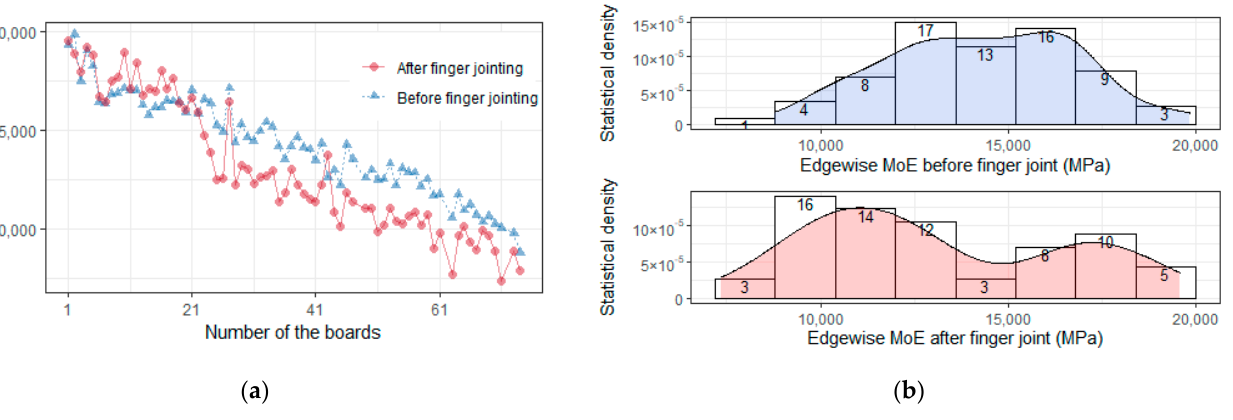
Figure 5. ( a ) Edgewise MoEs of the boards before and after finger jointing; board number 1 had the highest mean value of flatwise MoE (14~17 sections) before finger jointing. ( b ) Histogram plots of edgewise MoEs before and after finger jointing.